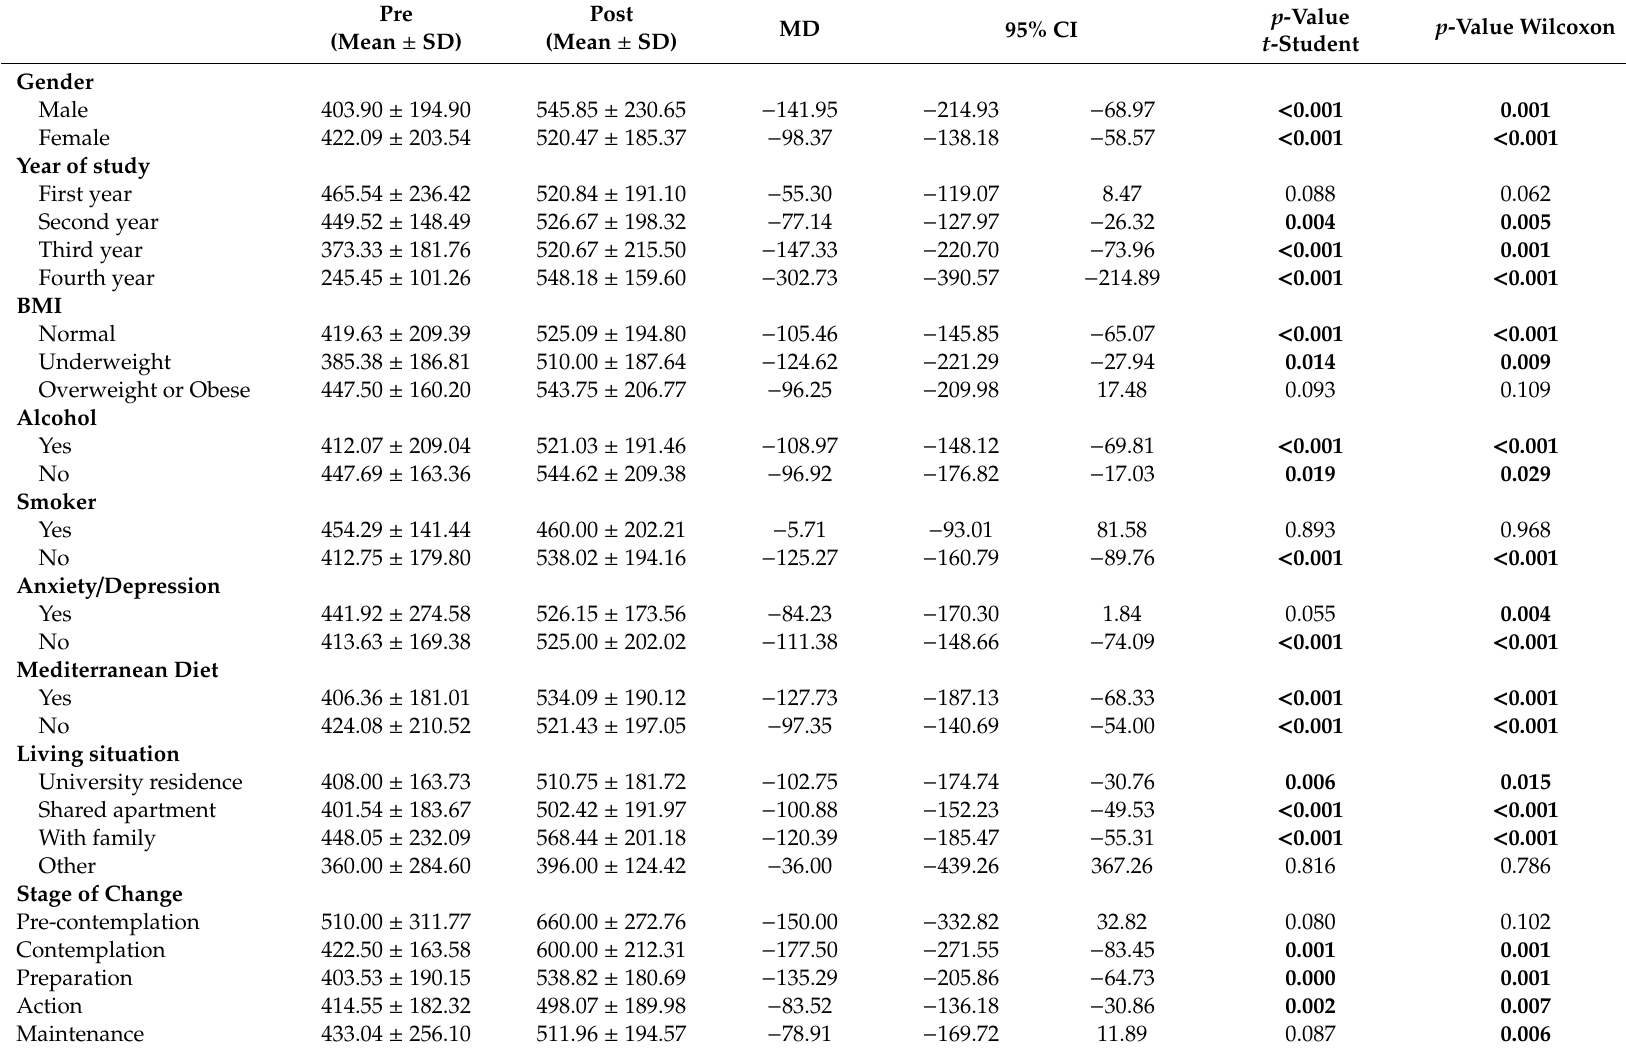
Table 4. Sitting time: daily minutes pre and post by